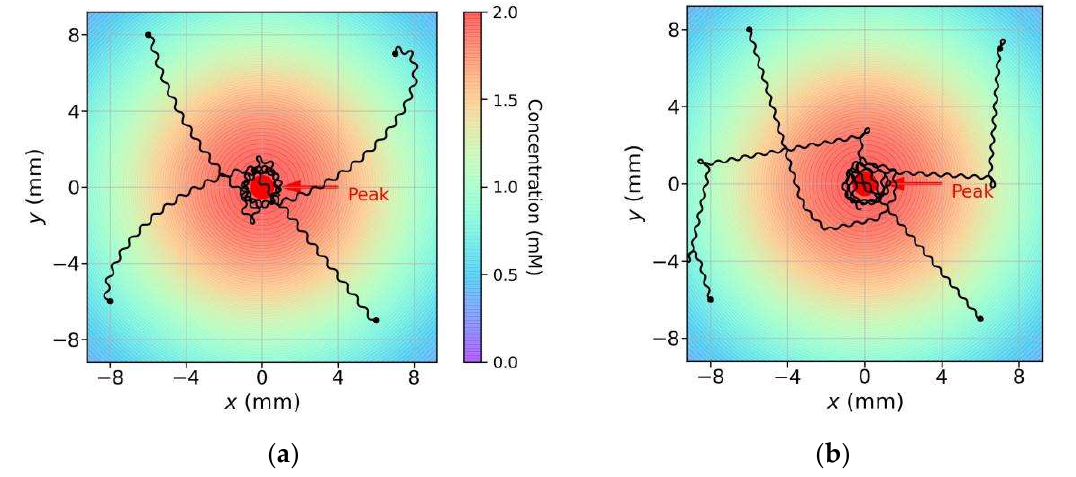
Figure 15. Search trajectories of our model (a); and the reproduced model (b) in the scenario used in